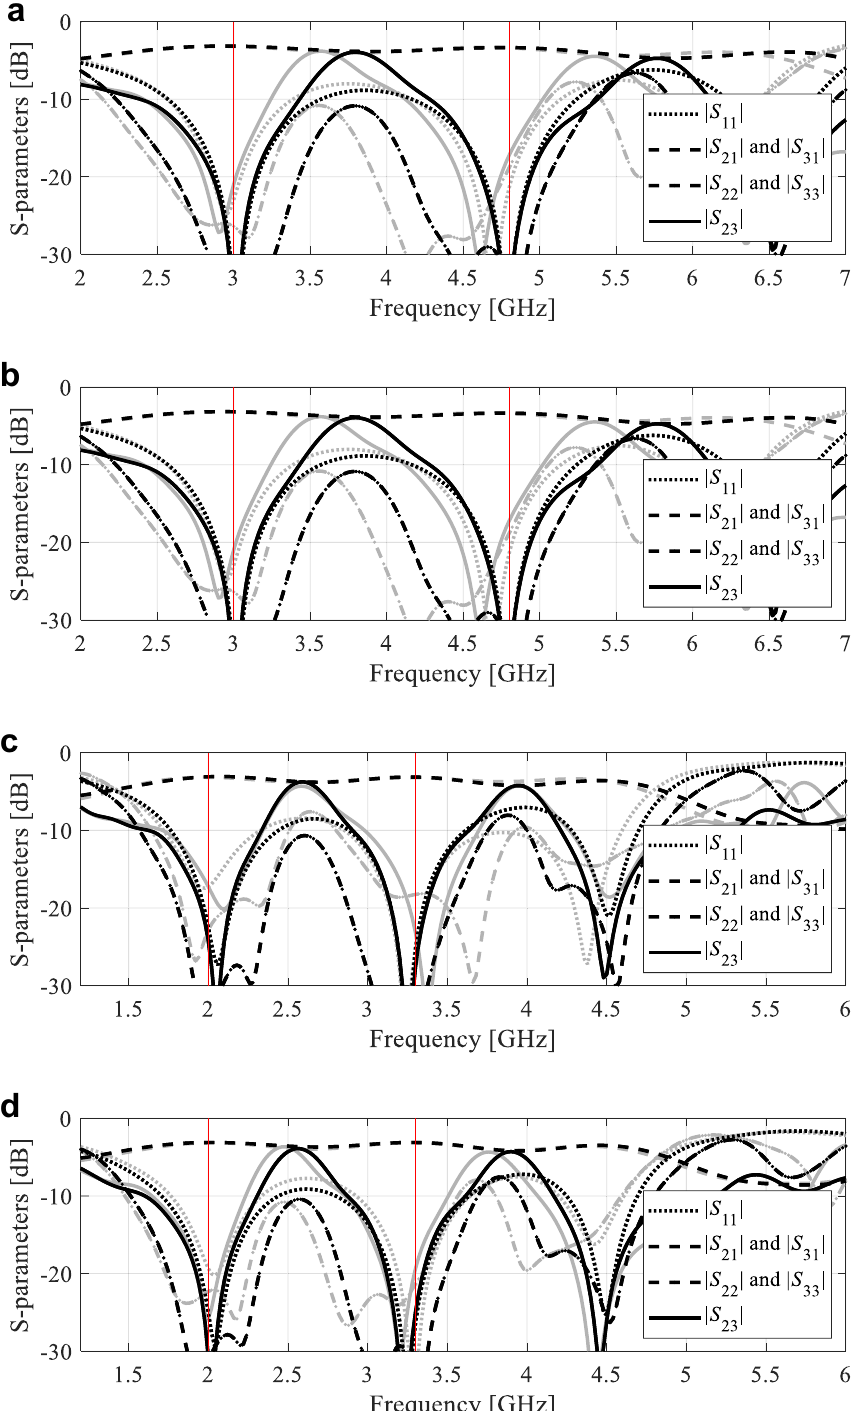
Figure 9. Circuit III: S-parameter characteristics at the optimized designs found by the proposed global optimization framework for two selected algorithm runs Case 1: ( a , b ) Designs 1 and 2, respectively, Case 2: ( c , d ) Designs 1 and 2, respectively. Gray lines correspond to the initial design x (0) obtained using the global search stage, black lines represent the responses at the final design. Vertical lines mark the target operating